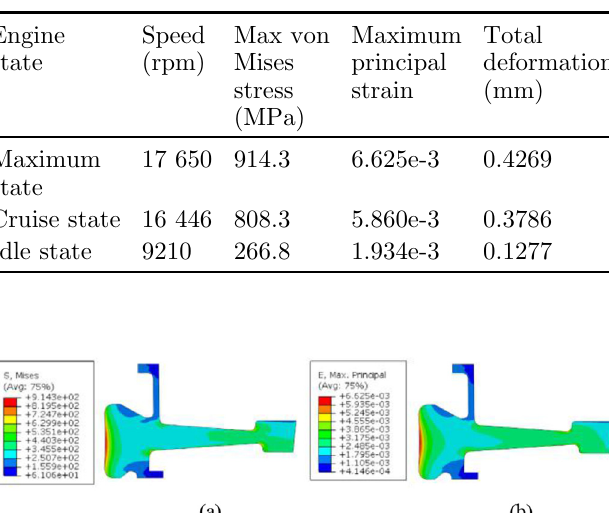
Table 6. Stress, strain, and total deformation of FGM turbine disc under different engine conditions.